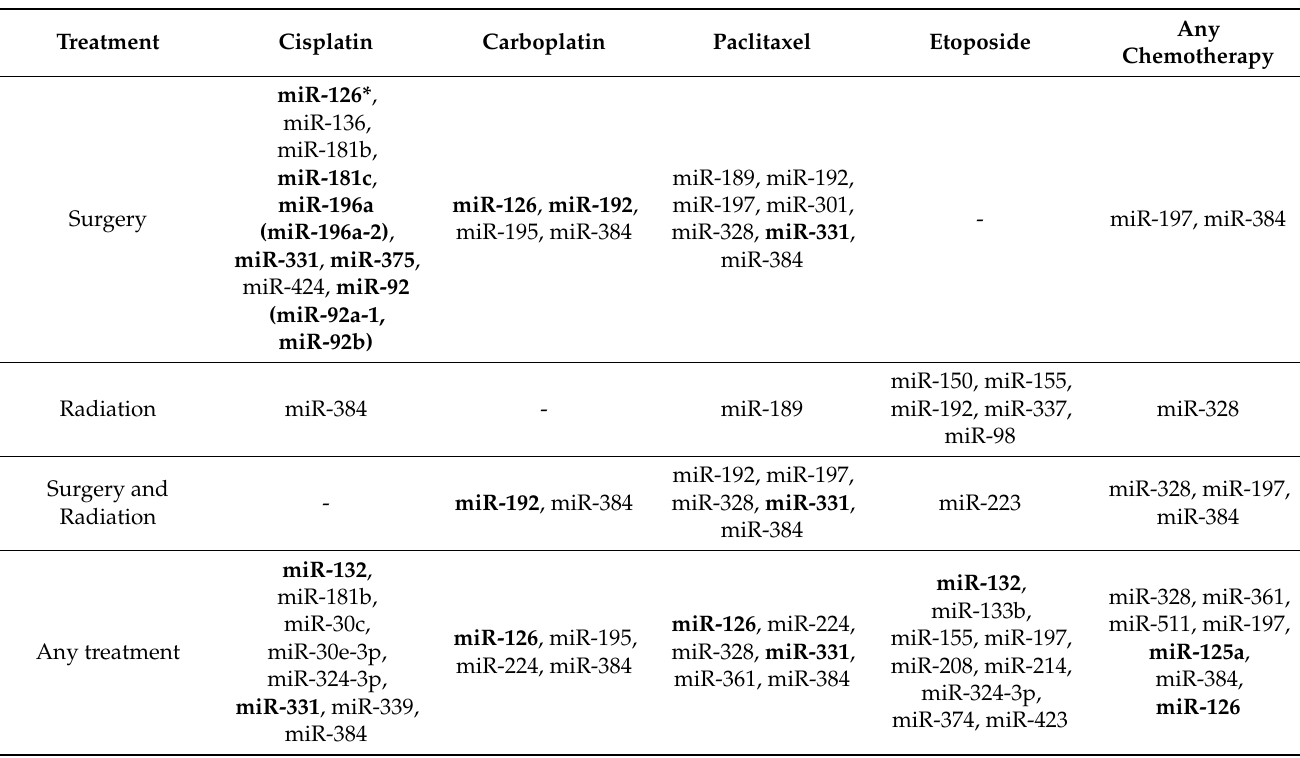
Table 4. Total number of chemoresistant miRNAs when considering administration of specific chemotherapeutic agents in combination with variable administration of surgery and radiation, as evidenced by shortened disease-specific survival. The miRNAs which produced a significant stratification in the SEER population samples in addition to significance on one or more measures in the NCI-60, MRRCC, CWRU, TCGA, and CCLE are in